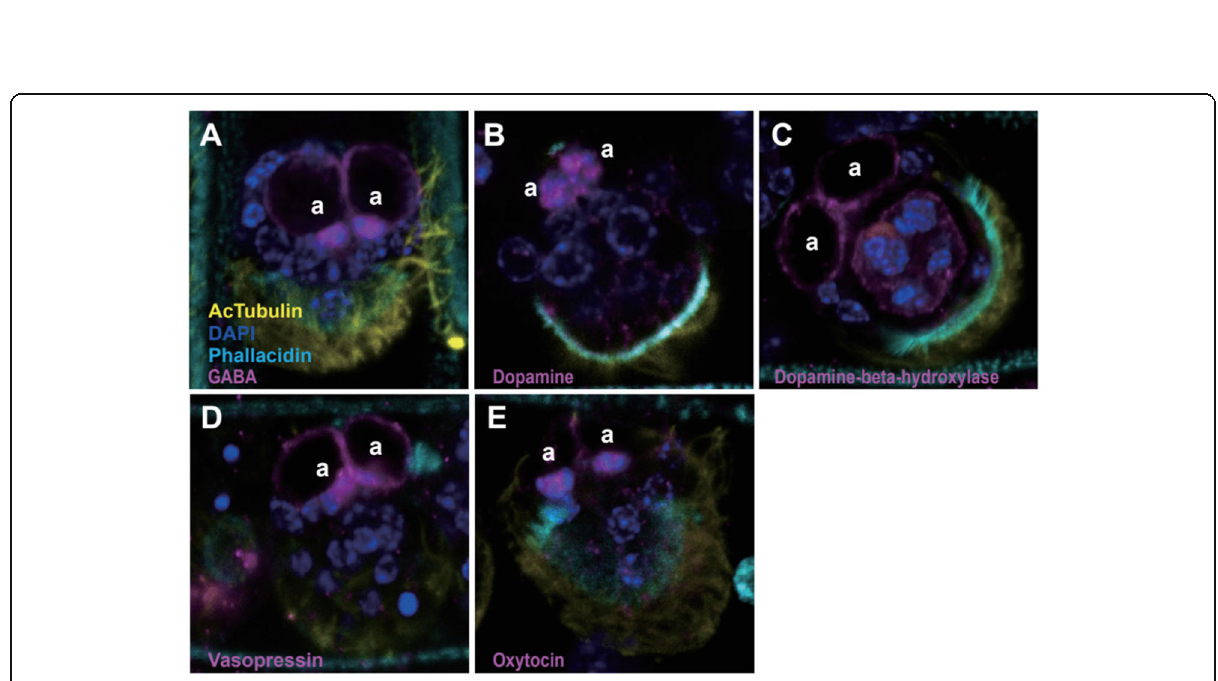
Fig. 4 Colocalization of potential neurotransmitters and neuropeptides in apical cells of infusoriform larva. Immunostaining signals of potential neurotransmitters and neuropeptides appear in apical cells of infusoriform larva, GABA ( a ), dopamine ( b ), dopamine beta hydroxylase ( c ), vasopressin ( d ), and oxytocin ( e ). Dopamine beta hydroxylase is also expressed in urn cells ( c ) inside the infusoriform larva. These results suggest that apical cells are likely the signal transduction center to receive environmental signals and to coordinate the release of germinal cells. Nuclei were labeled with DAPI (blue), and acetylated tubulin antibodies were used to label cilia (yellow). a, apical